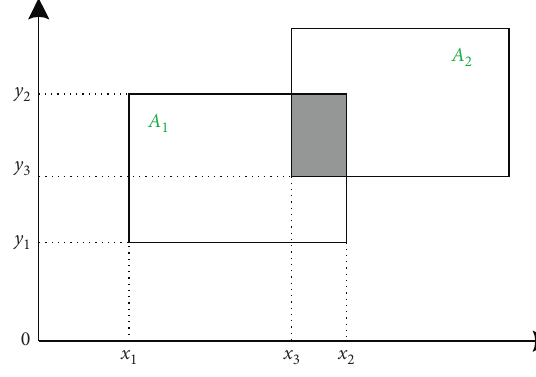
Figure 7: Schematic diagram of the feasible solution of the two- dimensional optimization problem. Table 1: Probability comparison of random initialization solutions for optimization problems in different dimensions.